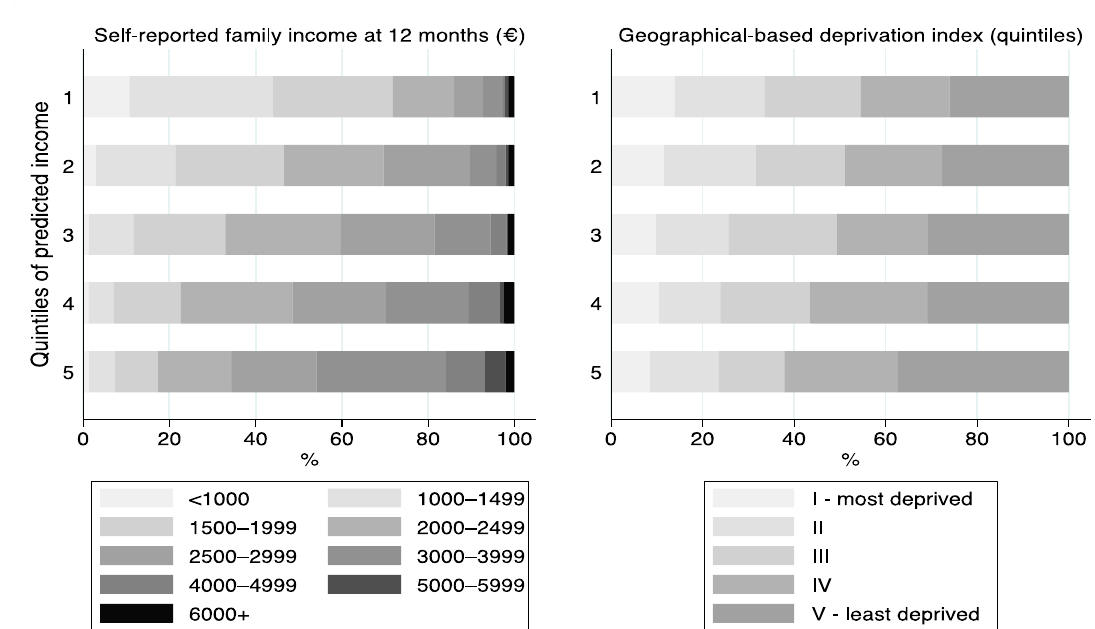
Figure 1. Distribution of the socioeconomic position (SEP)-related variables available in the Piccolipiù cohort by quintiles of the predicted income.